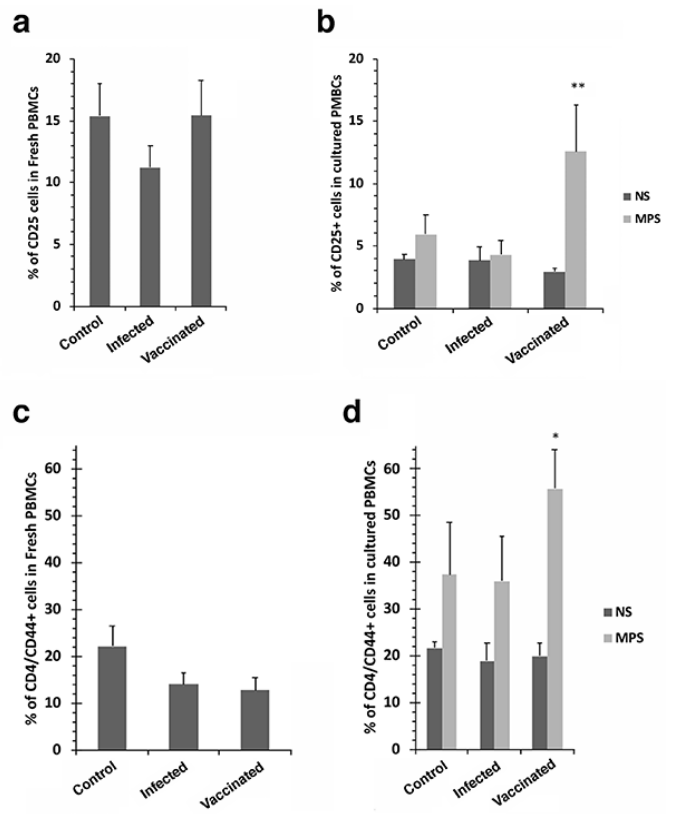
Figure 2. CD25+ and CD4/CD44+ T cell proliferation of cultured PBMCs in response to Map antigen. The percentage of CD25+ T cells in freshly isolated PBMCs are shown in ( a ) while cultured PBMCs from the same treatment groups are shown in ( b ). The same arrangement is shown for the CD44+ subpopulation of CD4 cells ( c , d ). Note the proliferation of CD25+ and CD44+ cells after stimulation with Map antigen ( b , d ). The double asterisk indicates a p value < 0.01 while the single asterisk indicates a p value < 0.05. Data are the average of duplicate trials ± standard error of the mean. The treatment groups are shown at the right of ( b , d ) (NS = no stimulation; MPS = stimulation with Map sonicate extract).